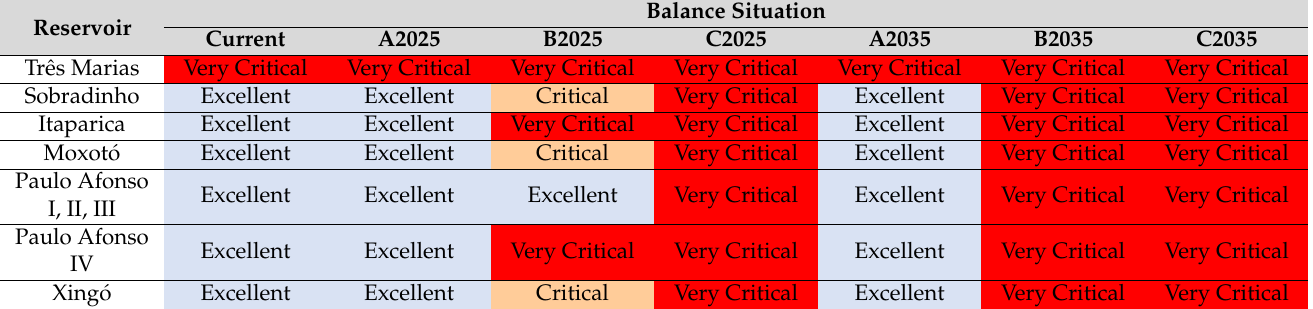
Table 9. Synthesis of the surface water balance (Acquanet)—energy. See Table 3 for the corresponding